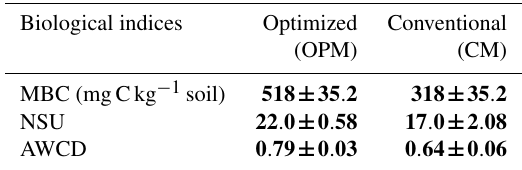
Table 5. Biological indicators. Mean ± standard deviation of the mean ( n = 3). Statistically significant differences ( p < 0 . 05) are in bold.